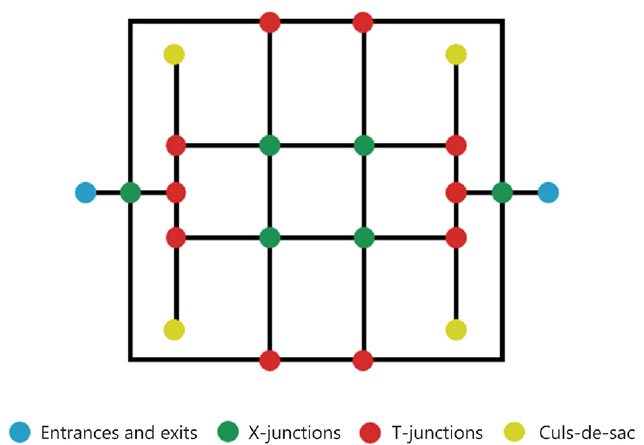
Figure 6. Schematic plot of Link-node.